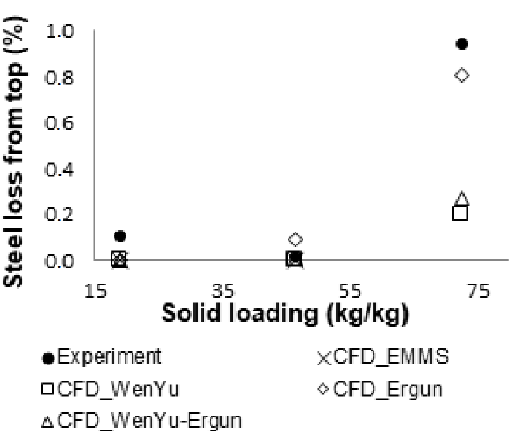
Figure 7. Steel particles exit from top when only steel particles are fed to the classifier